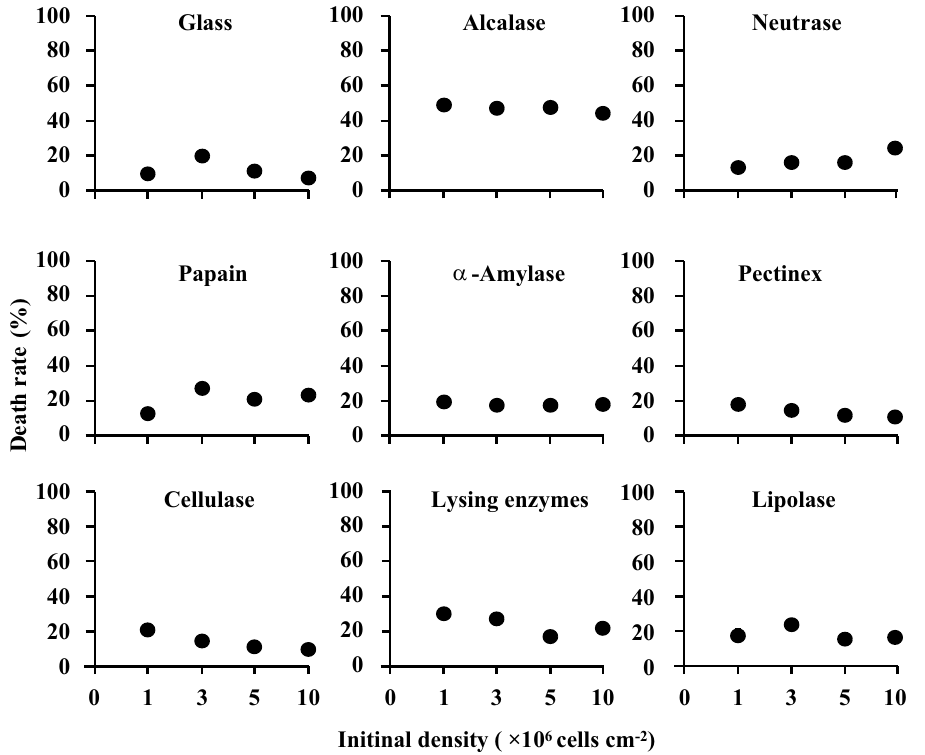
Figure 4. Dead bacterial density on S. marisflavi biofilm with different enzymes treatments.